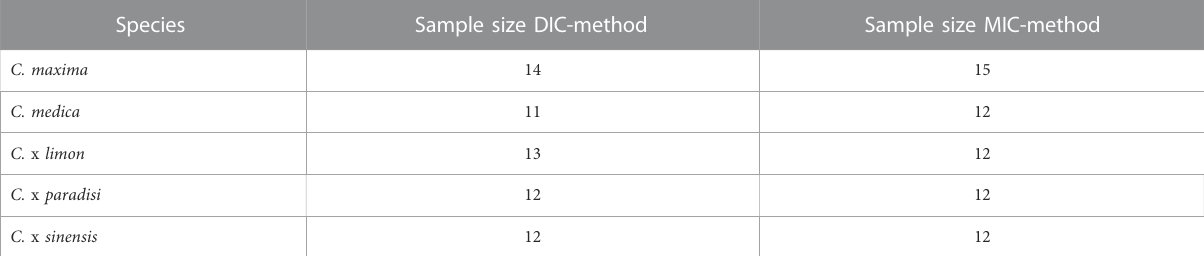
TABLE 2 Sample sizes of the species used of Citrus spp. [pomelo ( C. maxima ), citron ( C. medica ), lemon ( C. x limon ), grapefruit ( C . x paradisi ), orange ( C. x sinensis )] for quasi-static compression tests with digital image correlation (DIC) or manual image correlation (MIC).